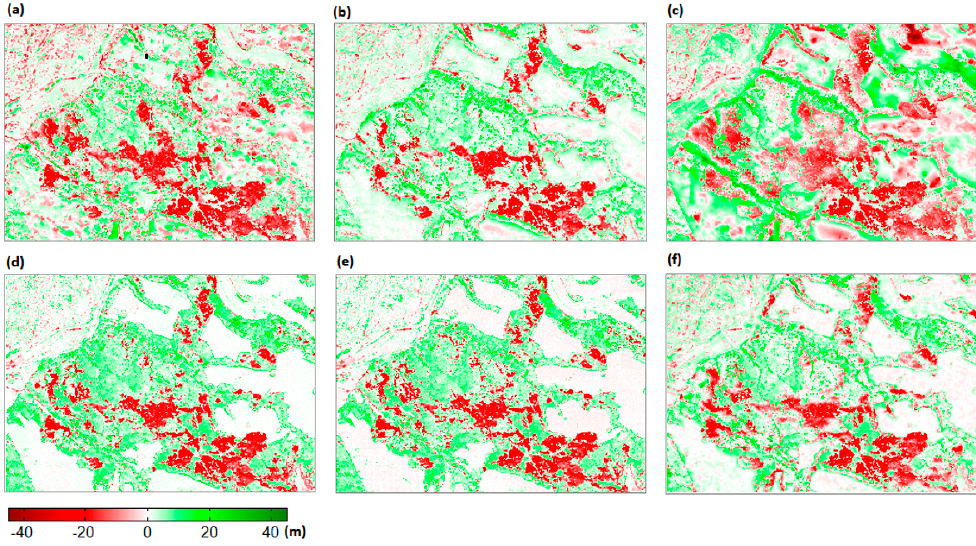
Figure 8. Height difference maps comparison: ( a ) ALOS2008–LiDAR2001; ( b ) Cartosat2008–LiDAR2001; ( c ) RapidEye2009–LiDAR2001; ( d ) WorldView2012–LiDAR2001; ( e ) Aerial2012–LiDAR2001; and ( f ) TanDEM-X2013–LiDAR2001.